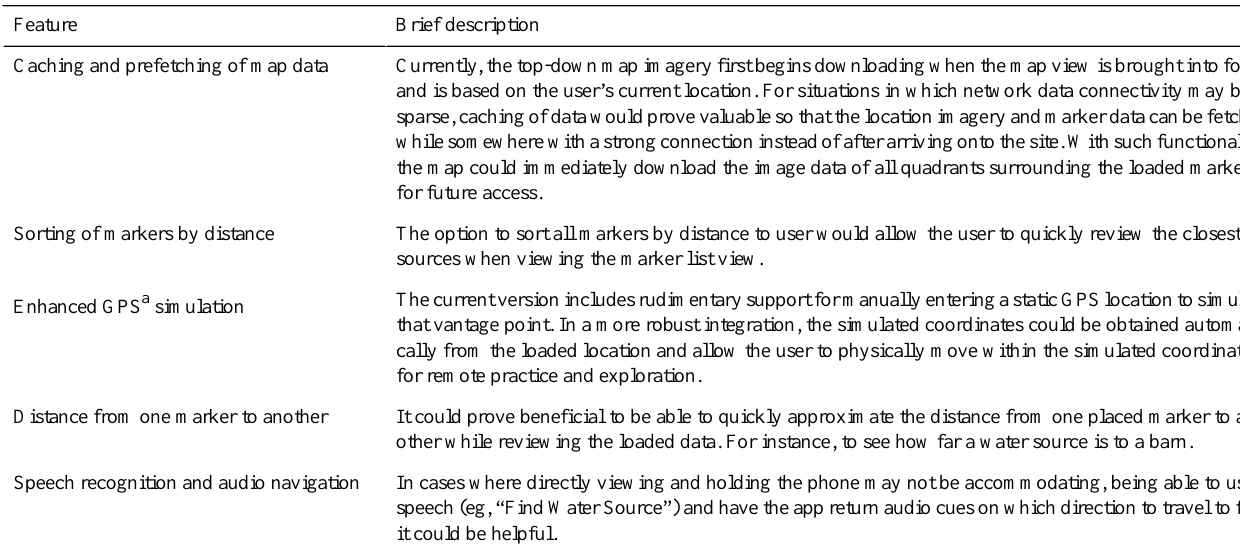
Table 1. Potential app features.